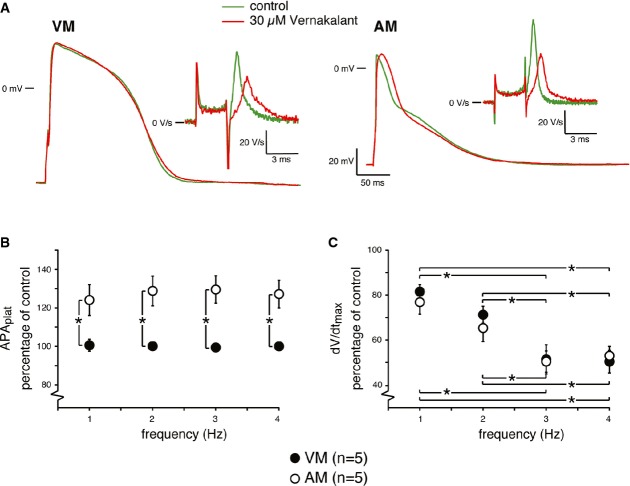
Effects of vernakalant on APs of hESC-ventricular and hESC-atrial CMs
A Representative APs at 1 Hz of VM and AM CMs in response to vernakalant. Inset shows dV/dtmax.

B, C Average APAplat (B) and dV/dtmax (C)in the absence and presence of vernakalant at 1–4 Hz. AP parameters are shown in Supplementary Table S6. Abbreviations as in Figs3 and 6.

Data information: Data are presented as mean ± SEM. *P < 0.05 by Mann–Whitney rank-sum test for (B). P = 0.01, 0.008, 0.008 and 0.007, respectively, for comparison of APAplat between VM and AM groups at frequencies of 1.0, 2.0, 3.0 and 4.0 Hz. Two-way repeated measures ANOVA followed by pairwise comparison using the Student–Newman–Keuls test for (C). P = 0.686 between VM and AM groups and hence not statistically significant. For VM, P = 0.06 for 1 versus 2 Hz; P < 0.001 for 1 versus 3 Hz; P < 0.001 for 1 versus 4 Hz; P = 0.001 for 2 versus 3 Hz; P = 0.002 for 2 versus 4 Hz; and P = 0.857 for 3 versus 4 Hz. For AM, P = 0.03 for 1 versus 2 Hz; P < 0.001 for 1 versus 3 Hz; P < 0.001 for 1 versus 4 Hz; P = 0.02 for 2 versus 3 Hz; P = 0.02 for 2 versus 4 Hz; and P = 0.621 for 3 versus 4 Hz.